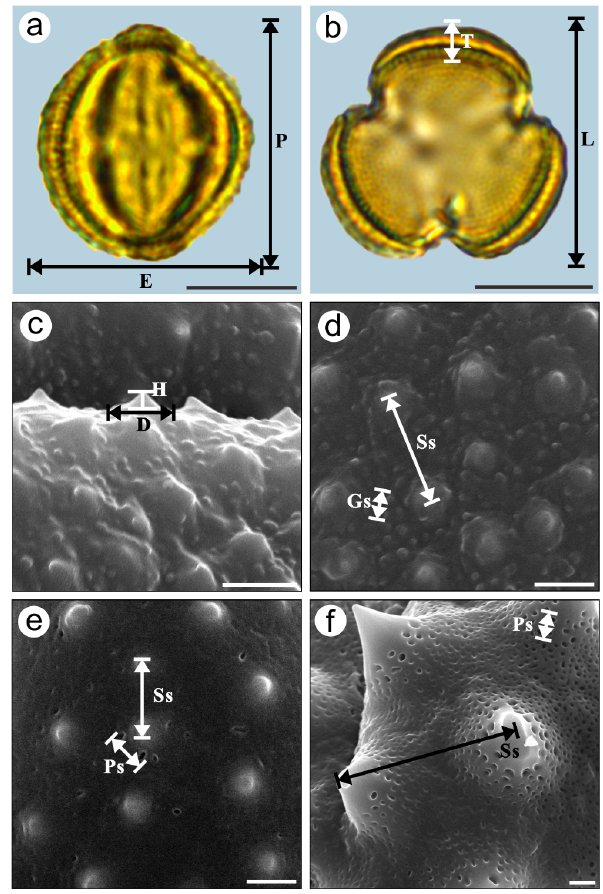
Figure 2. Graphical illustration of measured pollen morphological traits in Artemisia (a, b : A. annua ; c, d : A. vulgaris ) and outgroups (e : Kaschagaria brachanthemoides ; and f : Ajania pallasiana ) . Scale bar in LM and SEM overview 10µm, and in SEM close-up